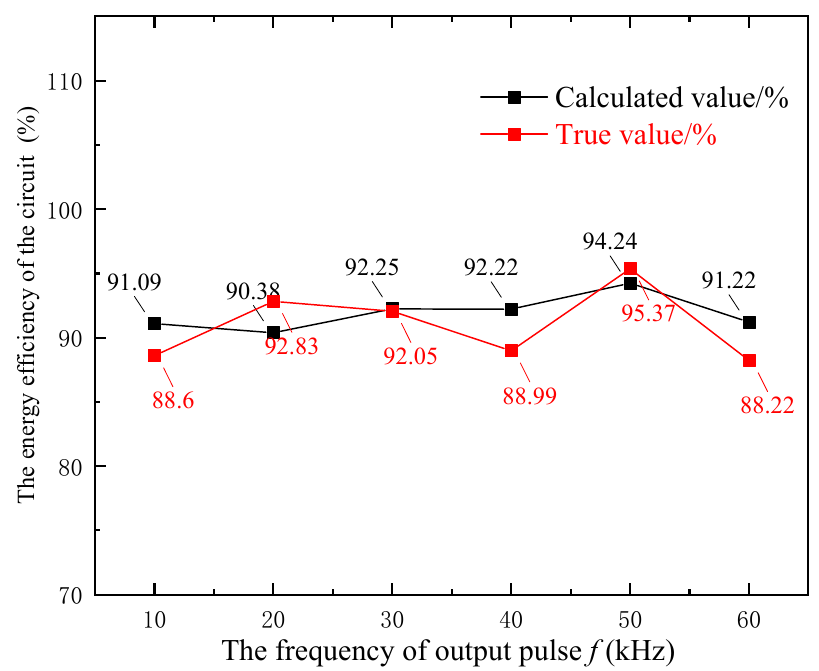
Figure 13. The power with a different output pulse frequency.